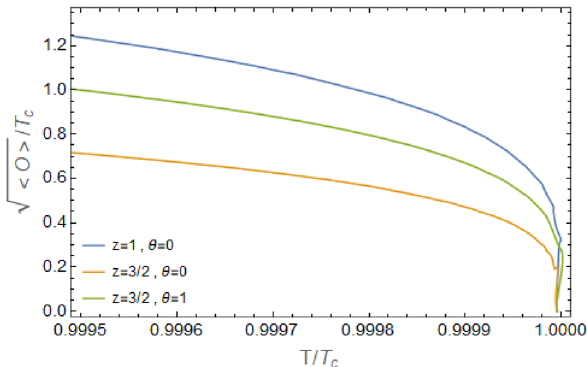
Fig. 8 The cooper pair condensate < O > with fixed α = 1 , x = 2. The blue line is for z = 1 ,θ = 0. The orange line is for z = 3 / 2 ,θ = 0. The green line is for z = 3 / 2 ,θ = 1. The condensate increases for bigger value of θ , but it is suppressed by